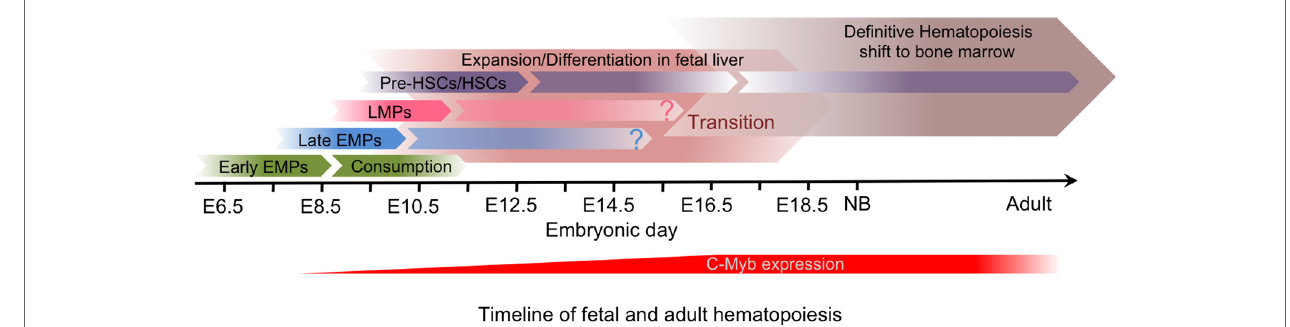
FiGURe 5 | Timeline of fetal and adult hematopoiesis . The primitive hematopoiesis is initiated in the yolk sac independently of C-Myb activity, and generates early CSF-1R + EMPs that give rise to YS macrophages without monocytic intermediates during a short time window and will establish the brain microglia. The transient definitive hematopoiesis and then the definitive hematopoiesis are both dependent on C-Myb activity and generate progenitors that differentiate in the fetal liver. The transient definitive wave, which include EMPs and then LMPs, give rise in particular to fetal monocytes that seed the tissues prior to birth to establish the self-renewing tissue-resident macrophage network. Although only HSCs, which result from the definitive hematopoiesis, seem to be maintained in the bone marrow in adults, the relative contribution of the transient definitive wave to the adult immune system remains